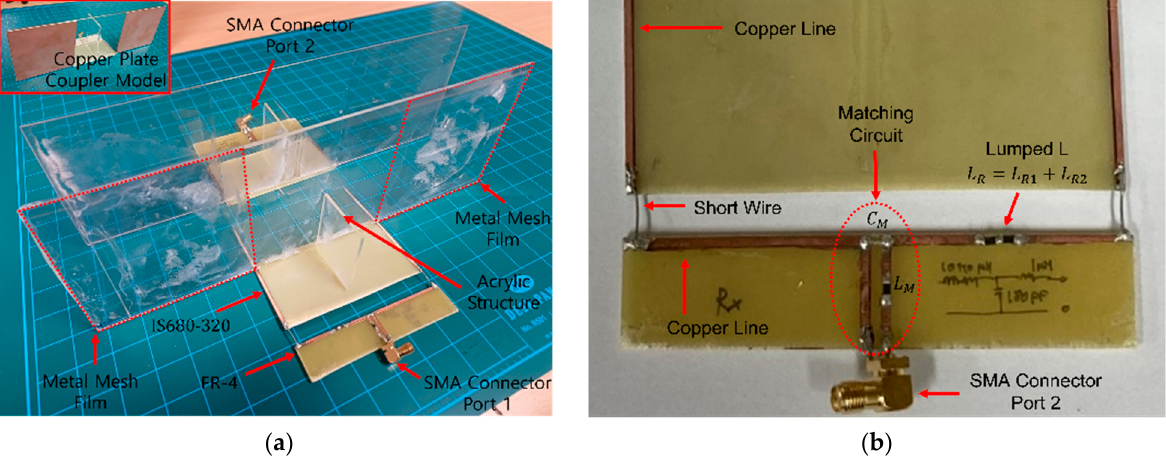
Figure 7. Fabricated proposed ER-WPT system. ( a ) Fabricated model. ( b ) Matching circuit structure.